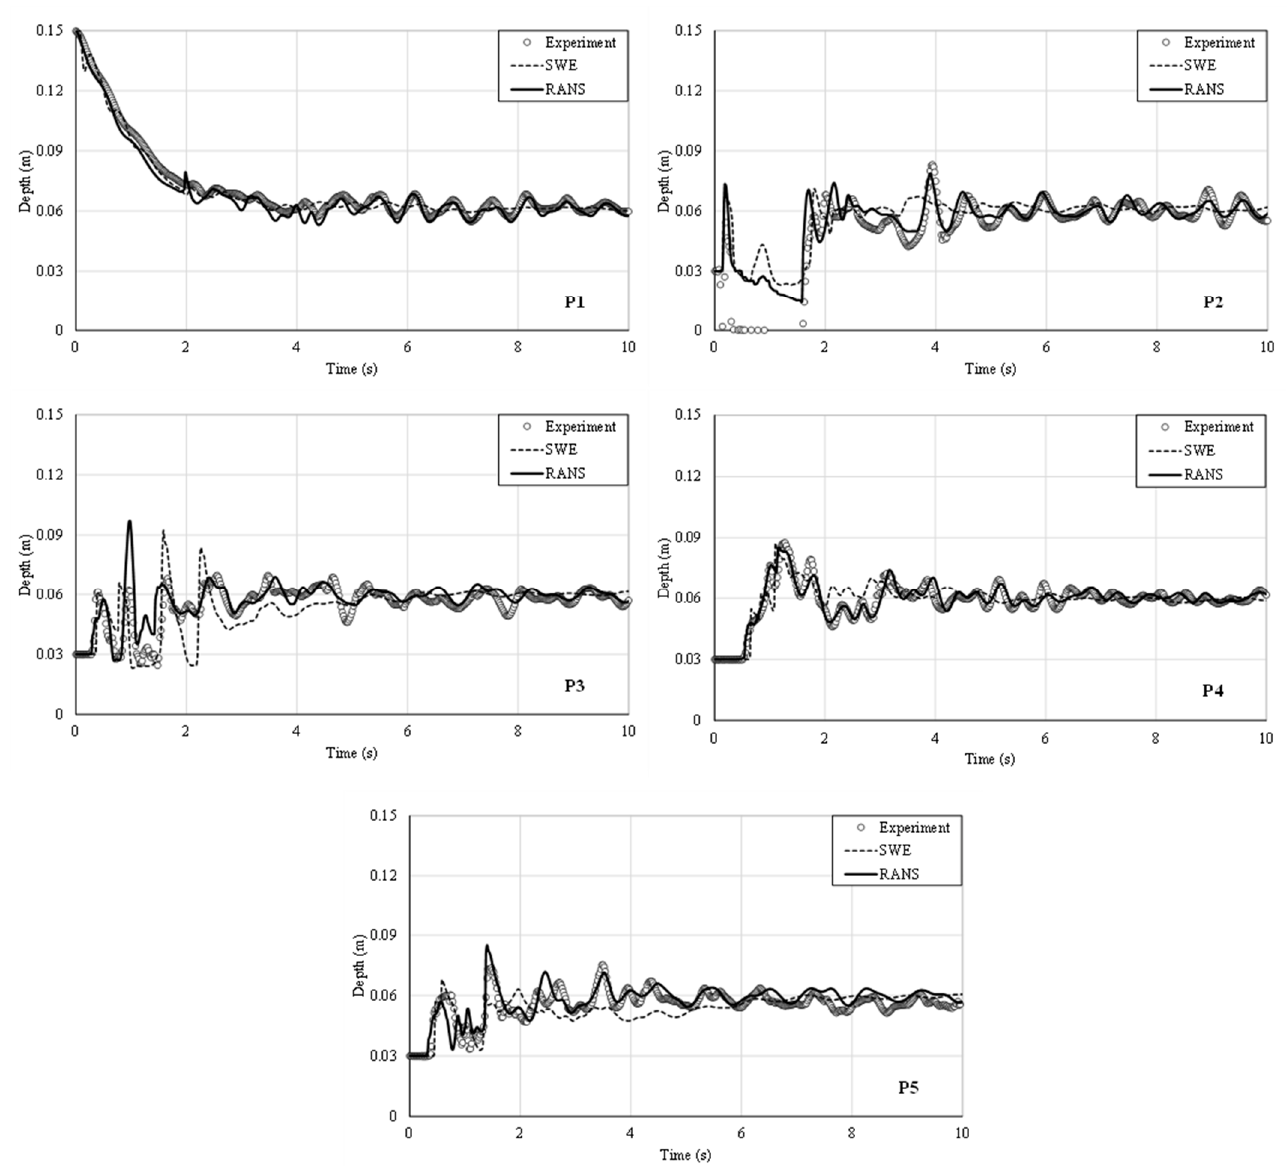
Figure 11. Comparison of experimental and numerical stage hydrographs (P1–P5 sensors) for test W2.